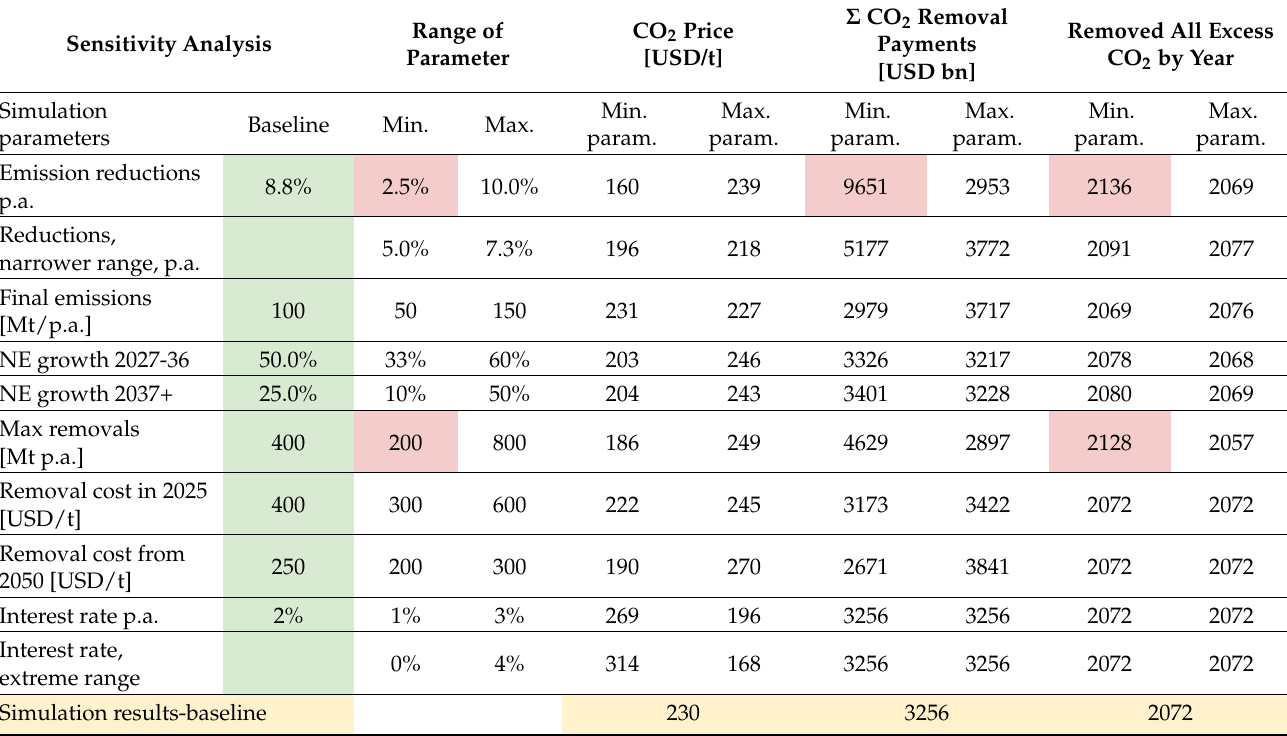
Table 1. Sensitivity analysis using one-at-a-time variation of baseline parameters (green), affecting the three main outputs (yellow); “problematic” outputs and associated inputs (red) are discussed